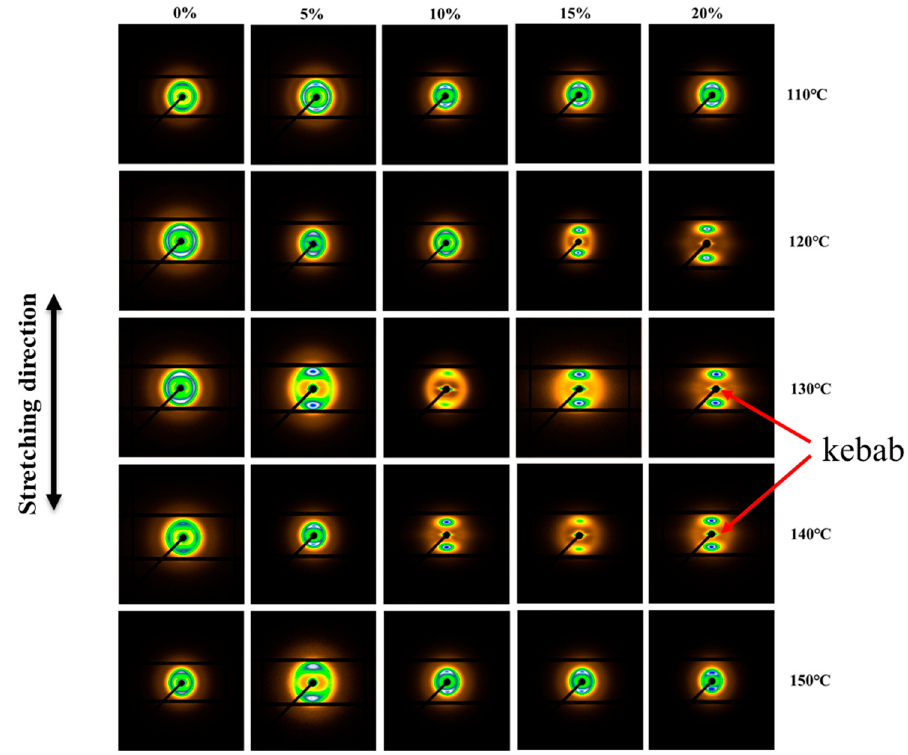
Figure 5. Two-dimensional small-angle X-ray scattering (2D-SAXS) patterns of the iPP sheet after stretching at different temperatures.